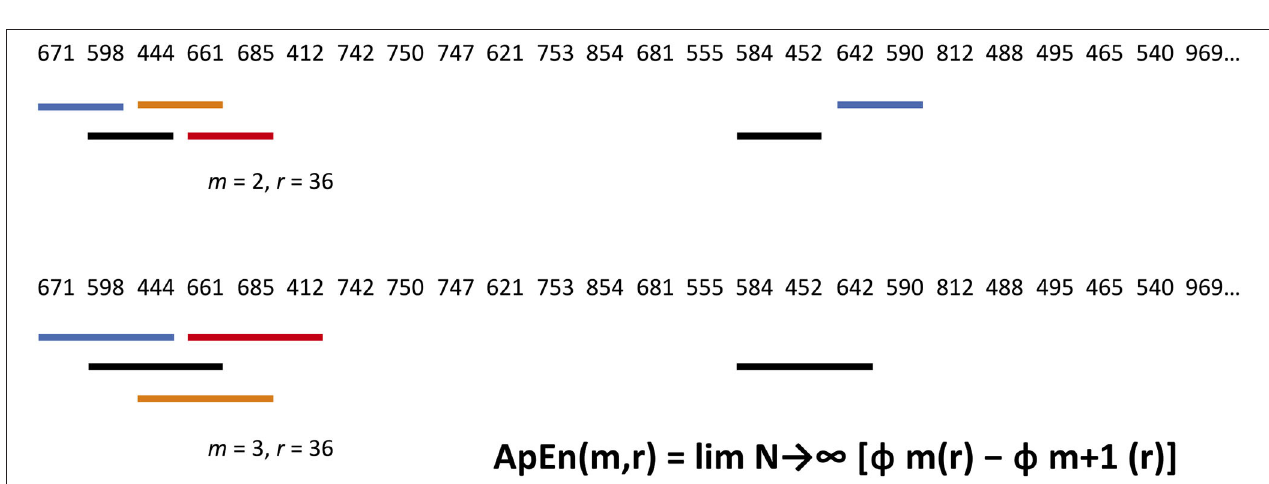
FIGURE 4 | Approximate Entropy algorithm applied to an annual rainfall (mm) series for Melbourne. Statistical properties of marginal probabilities are a shortcut to the probability character of a whole sample. A block size m and scaling or filter parameter r are selected. Here, m = 2, and r = 25% of the standard deviation. Blocks are assessed in turn for matches—BOTH corresponding numbers must lie within the ± 36 filter. In the top row, Block 1 matches with Block 17, and Block 2 with Block 15. In the bottom row, m has been raised by one—all 3 numbers must correspond to within ± 36. Block 2 with Block 15 is a match. All m = 2 and 3 matches are then tallied to calculate Approximate Entropy. Interested readers can find theoretical and practical treatments of information entropy measurement elsewhere (78).